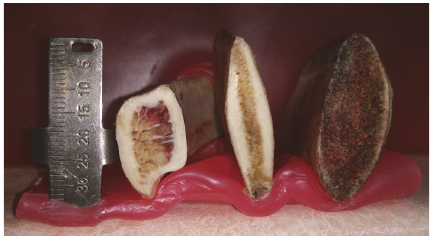
Figure1:Bonesectionofdifferentpartsofrib.Thebeginningpartof the ribs was used in this study (adjacent to the index in the picture).